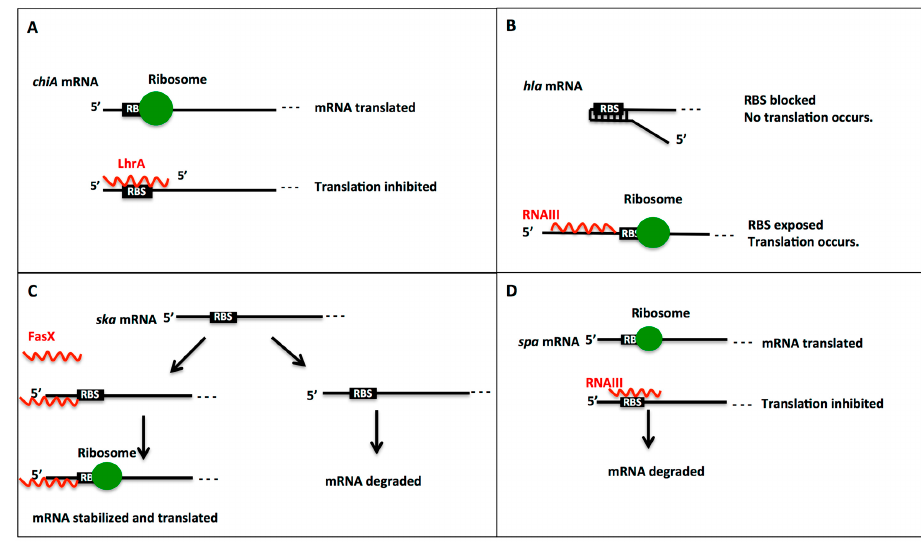
Figure 1. Regulation mechanisms of gene expression by sRNAs. ( A ) Translation repression by sRNA-binding. Small RNA LhrA regulates chitinolytic activity in L. monocytogenes through binding to chiA mRNA. LhrA binding negatively regulates chitinolytic activity through binding to the RBS and inhibiting translation. Extensive complementarity exists between the 3’-end of LhrA and the 5’-end of chiA mRNA. Without LhrA bound to the chiA mRNA, the ribosome can bind the RBS and translate the mRNA; ( B ) Translation activation by sRNA-binding. The S. aureus hla encodes extracellular α -hemolysin. When RNAIII is not bound to the hla mRNA, the mRNA conformation blocks the RBS and translation cannot occur. After RNAIII binds to the hla mRNA through a loop–loop interaction, the RBS is exposed and translation occurs; ( C ) Stabilization of mRNA by sRNA-binding. The most studied small RNA in S. pyogenes , FasX, positively regulates streptokinase through increasing the stability of the ska transcript. The binding of FasX to the 5’-end of the ska mRNA transcript protects the mRNA from degradation, so increases the abundance of streptokinase. Without the binding of FasX, the ska mRNA is degraded by RNases; ( D ) Promotion of mRNA degradation by sRNA-binding. An increase in target mRNA degradation occurs after the binding of RNAIII to the spa mRNA in S. aureus . Without RNAIII bound to the spa mRNA, the ribosome can bind and translation can proceed. When RNAIII binds, the loop–loop interaction between hairpin 13 of RNAIII and the spa mRNA complex not only inhibits the translation but also promotes the degradation of the spa mRNA in order to permanently stop translation.